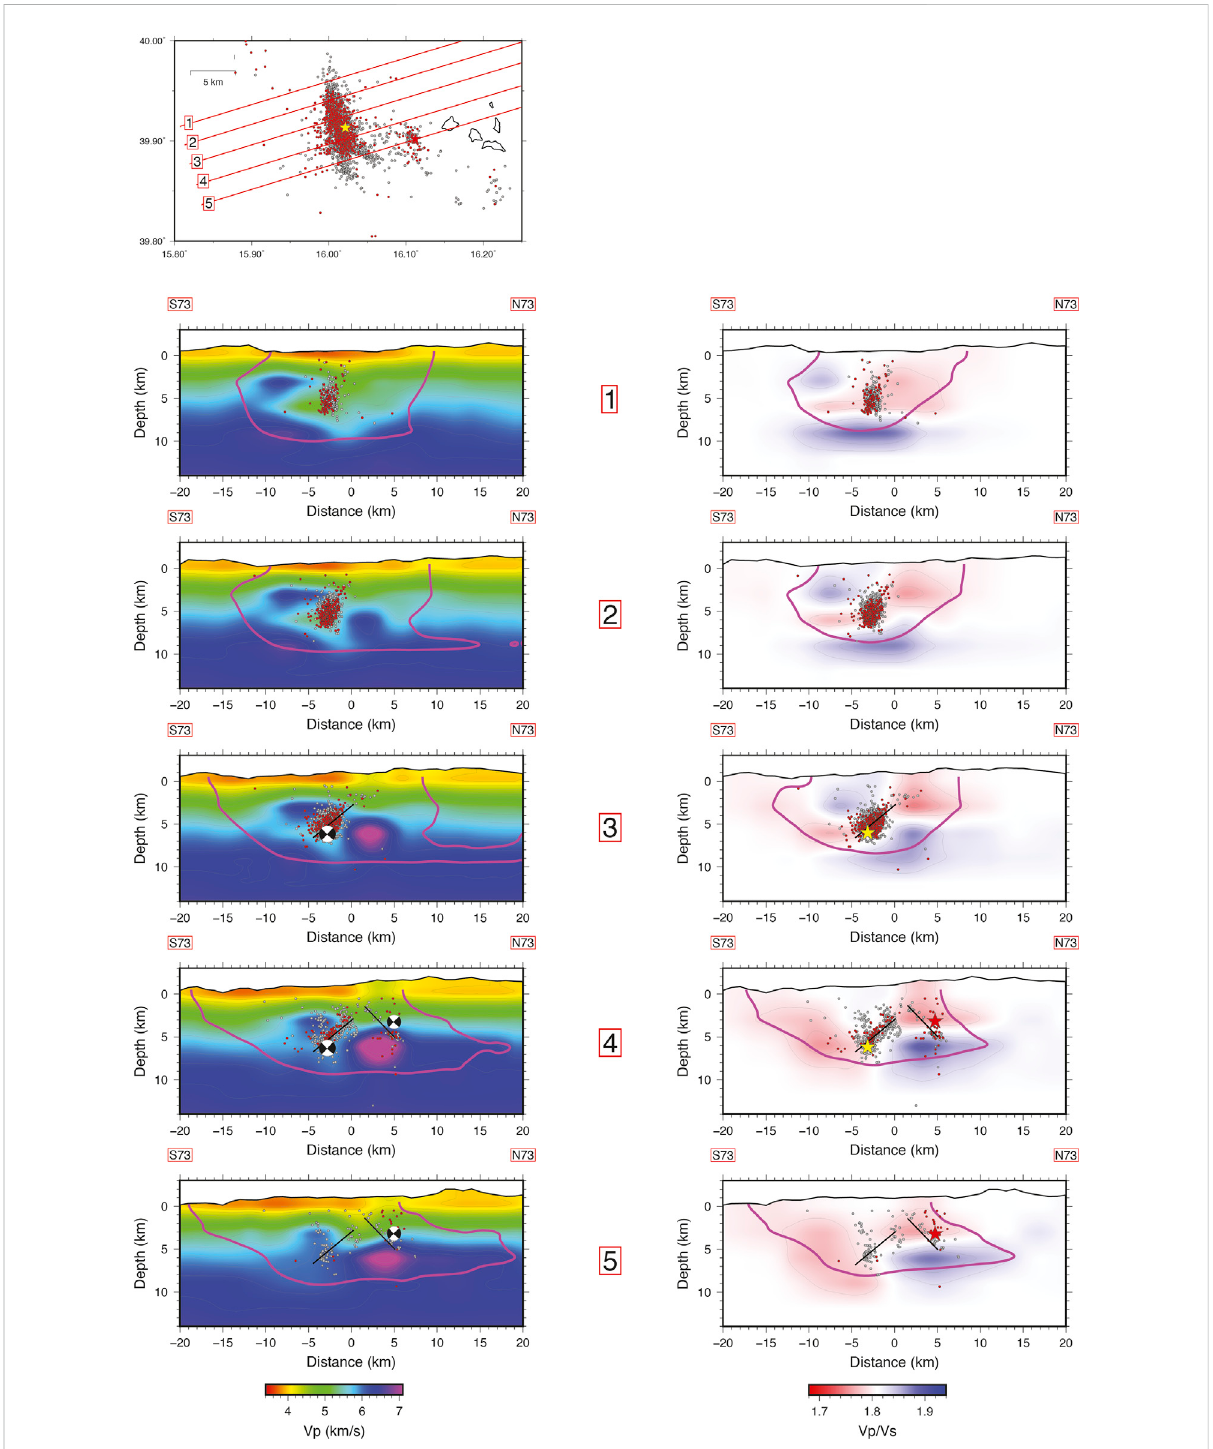
FIGURE 5 VerticalcrosssectionsofVp(ontheleft)andVp/Vsmodels(ontheright)acrosstheinvertedmodels.Thetracesofthe fi veVpandVp/Vsvertical sections are indicated by red lines on themap in thetop panel. Each trace isseparated by 2.5 km, and the width for plotting earthquakes is±1.25 km. Color scales are as indicated in Figure 4; the purple contour line represents the well resolved area in each section. Hypocenters of the relocated events occurred before and after the25October 2012 M L =5.2 are represented as redand graycircles, respectively. Thetwo main earthquakes are represented by their focal solution (http://cnt.rm.ingv.it/tdmt.html; Scognamiglio et al., 2009) on the Vp cross sections (on the left), and by red- (28May 2012, M L = 4.3) and yellow stars (25October 2012, M L = 5), respectively, on theVp/Vs sections(on theright).Black line segments inSections 3 – 5, on both Vp and Vp/Vs models, are the possible fault planes owing to the two main